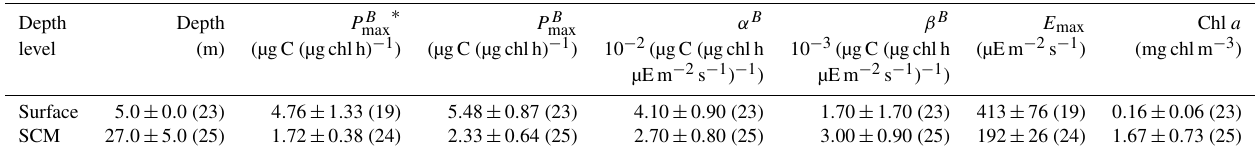
Table 1. Distribution of photosynthetic parameters. Median values and absolute median deviations (number of samples n in parenthesis) of photosynthetic parameters at 5m below the surface and at the